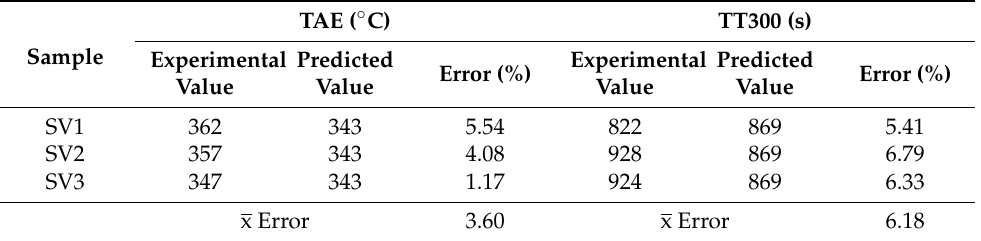
Table 8. Experimental validation for the temperature at equilibrium and time taken to reach 300 ◦